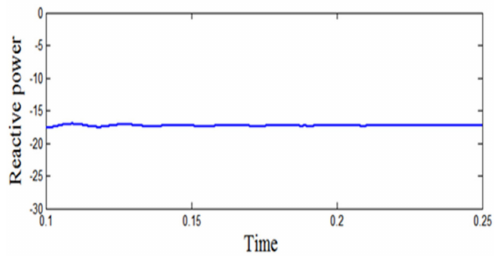
Figure 34. Reactive power from bidirectional